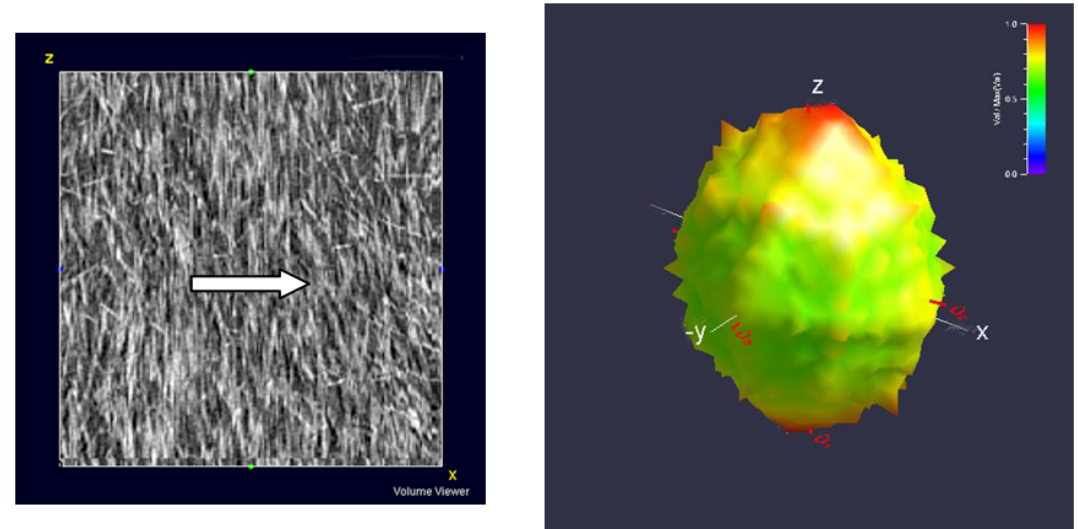
Figura 13: Zona core – Ricostruzione tomografica della distribuzione delle fibre (la freccia indica la direzione del flusso d’iniezione) e rappresentazione polare del MIL nelle direzioni di misura.